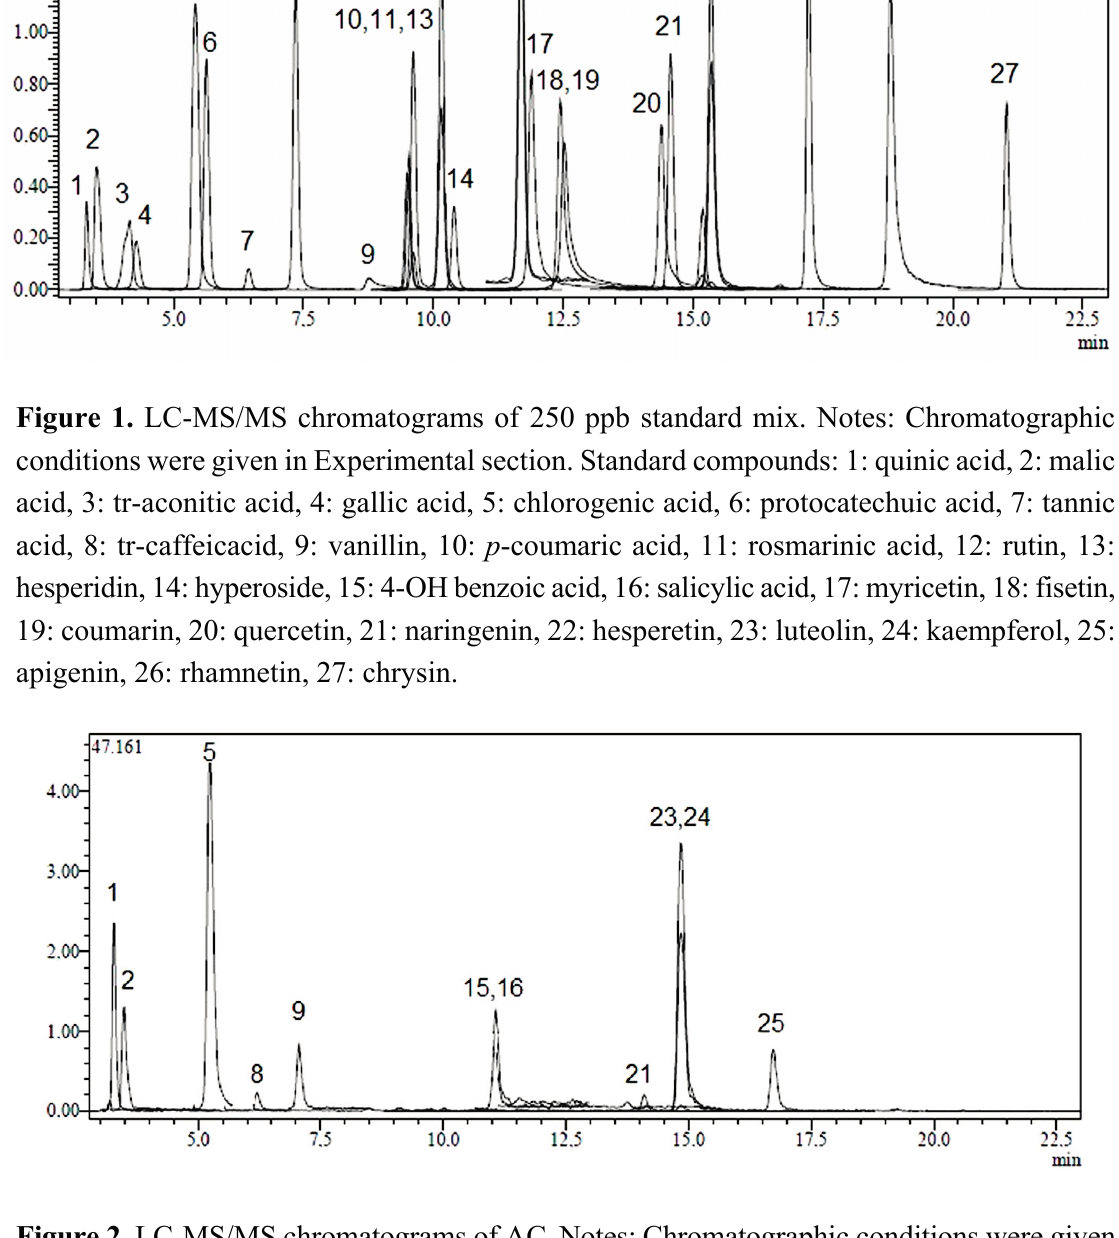
Figure 2. LC-MS/MS chromatograms of AC. Notes: Chromatographic conditions were given in Experimental